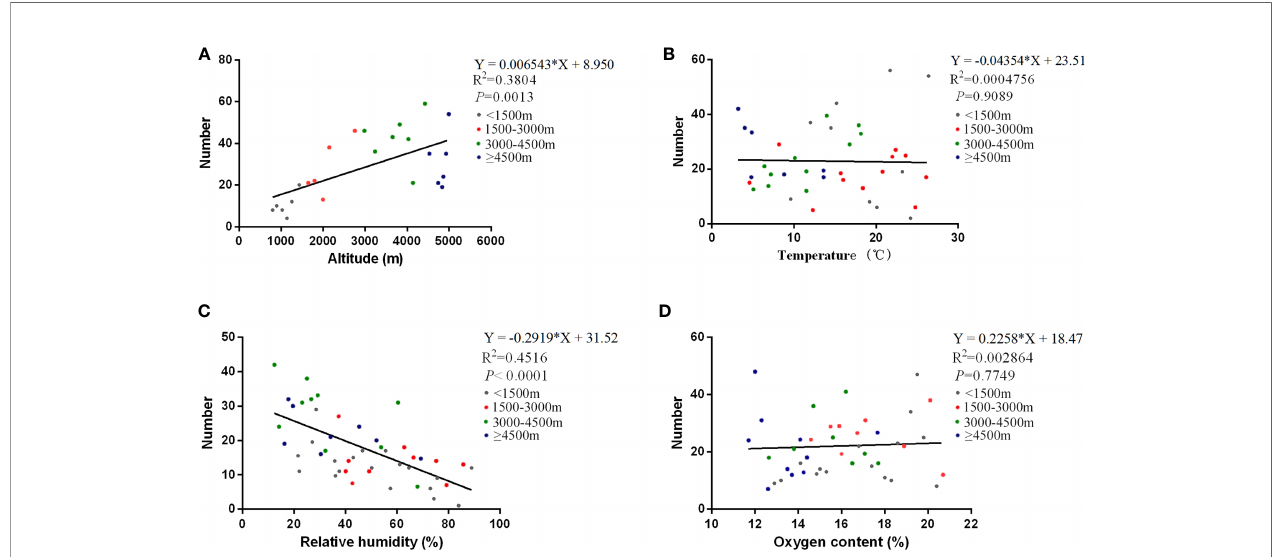
FIGURE 1 | Correlations of the number of patients with various environmental factors. The correlations of the number of HAdV infections with various environmental factors are shown in altitude (A) , temperature (B) , relative humidity (C) , and oxygen content (D) , respectively. The curves in the fi gure are derived from the Poisson regression model. The equation, correlation coef fi cient, and P -value of the curves are marked at the top right of every